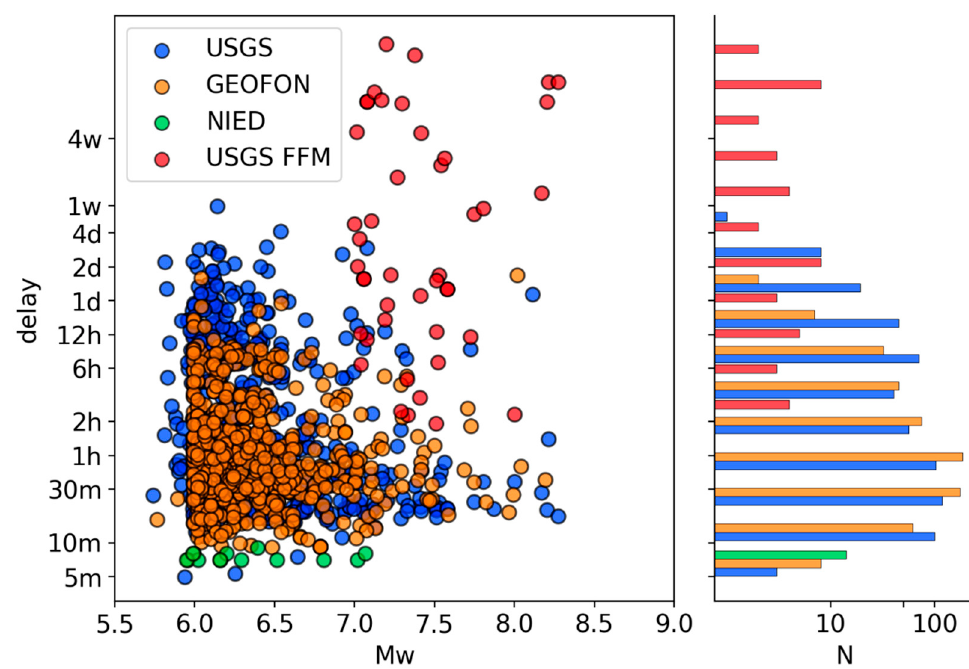
Figure 7. Time delays of information concerning earthquake sources.